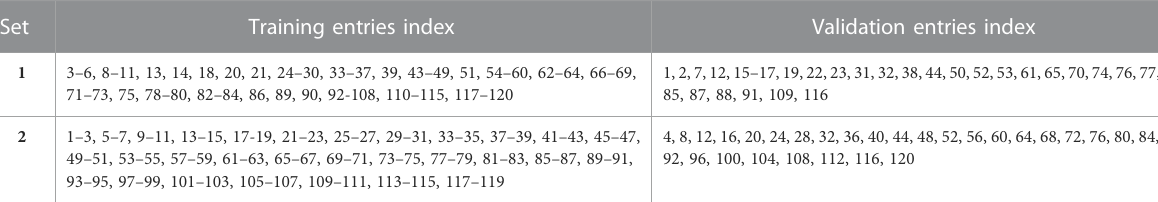
TABLE 2 Training and validation sets 1 and 2.